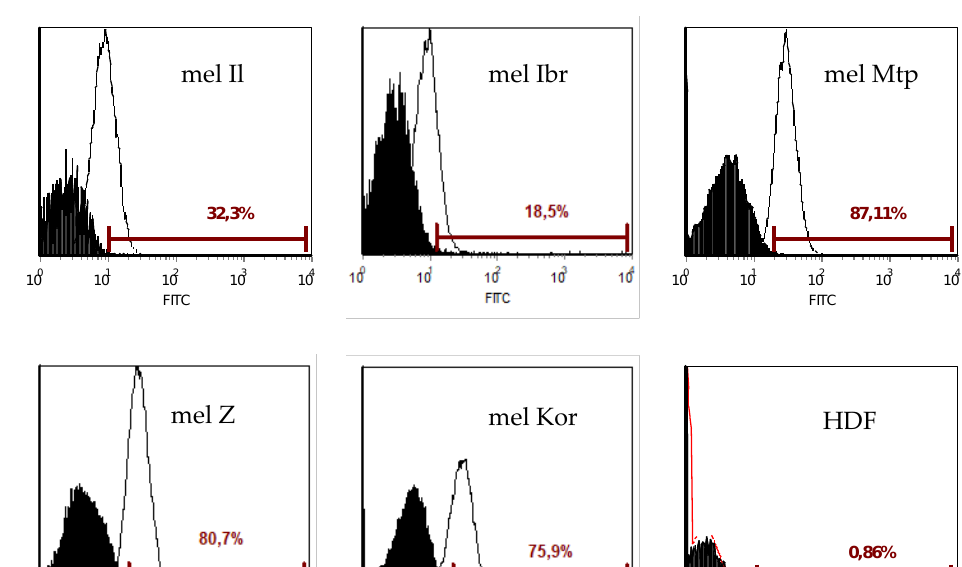
Figure 7. Inhibition of viral load in melanoma cells by mAbs against CD46. Mel Z cell line was incubated with increasing concentrations of mAbs or isotype control mAbs for one hour, washed with PBS and infected with MV at a MOI of 1.0. Viral load was measured in cell lysates by qPCR-RT after 4 h of incubation and the impact of anti-CD46 mAbs was expressed in % relatively to infected cells incubated with isotype control mAbs. The data shown are mean results from three independent experiments; error bars indicate standard deviation.